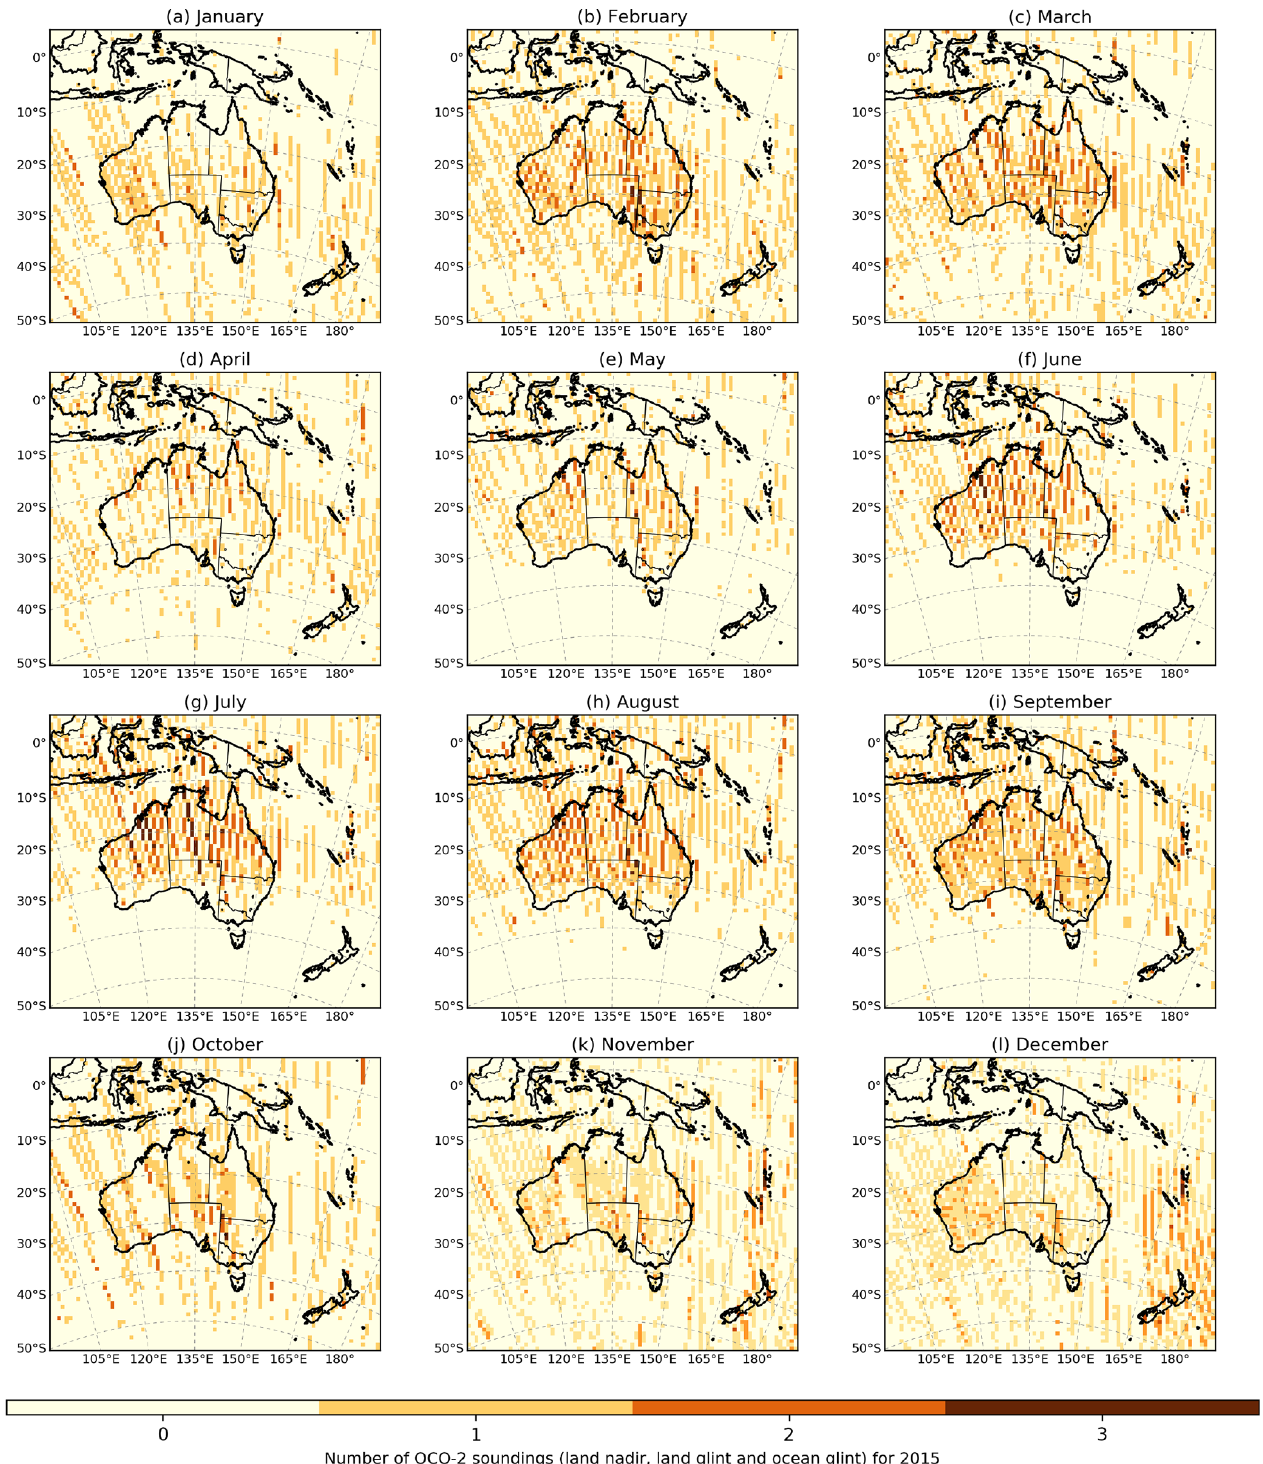
Figure C2. Spatial distribution of OCO-2 soundings (LNLGOG) over the CMAQ domain for 2015.